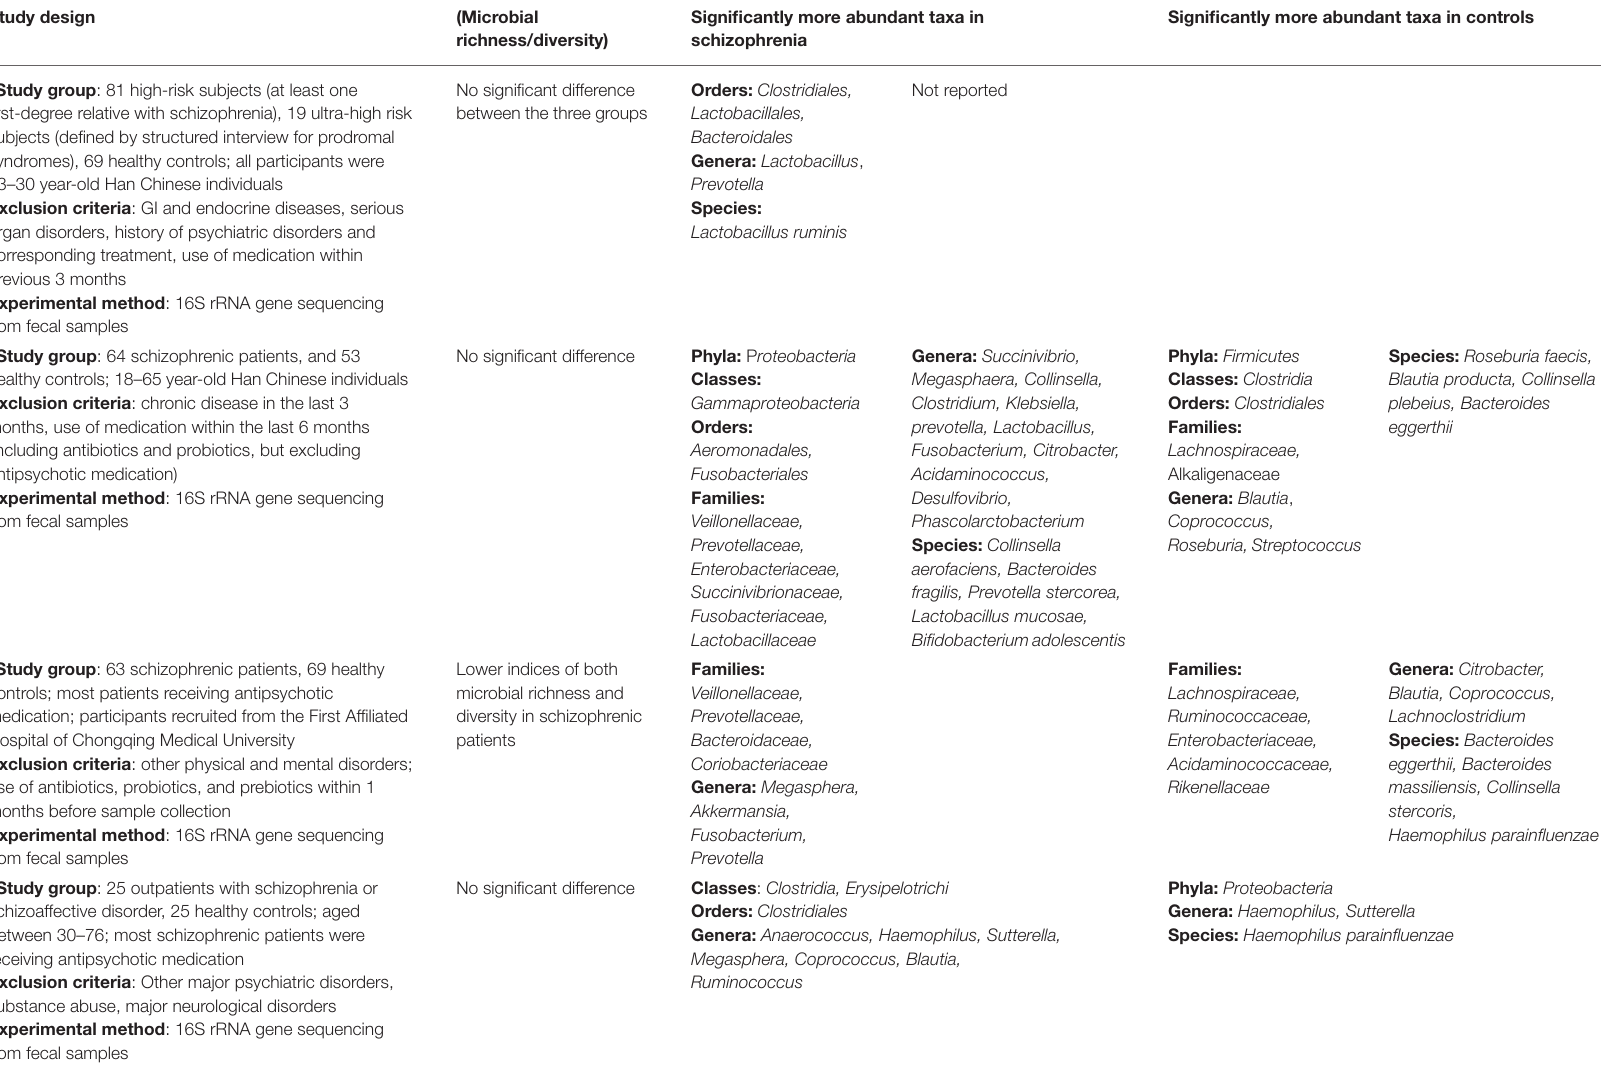
TABLE 1 | Summary of studies implicating dysbiosis in